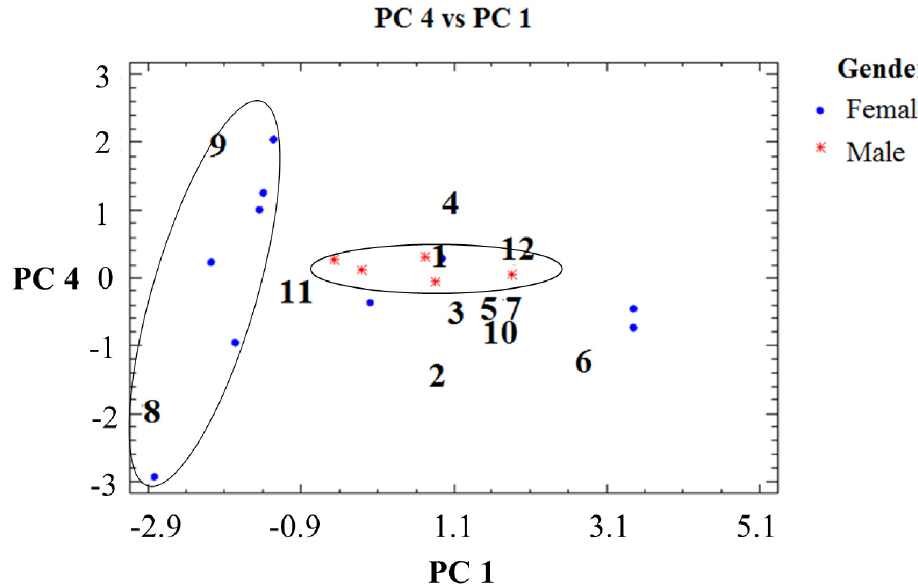
Figure 5. Graphic display of variables for selected components in the November